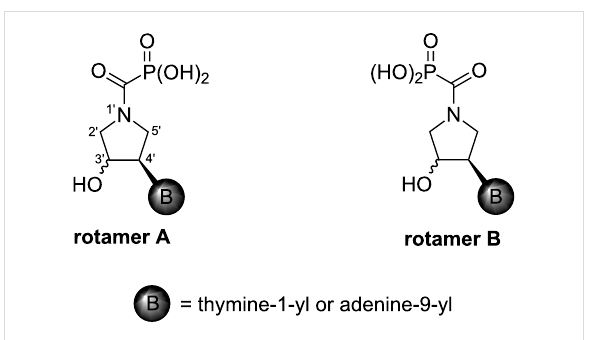
Figure 8: Amide rotamers of phosphonoformyl derivatives 11–14 .